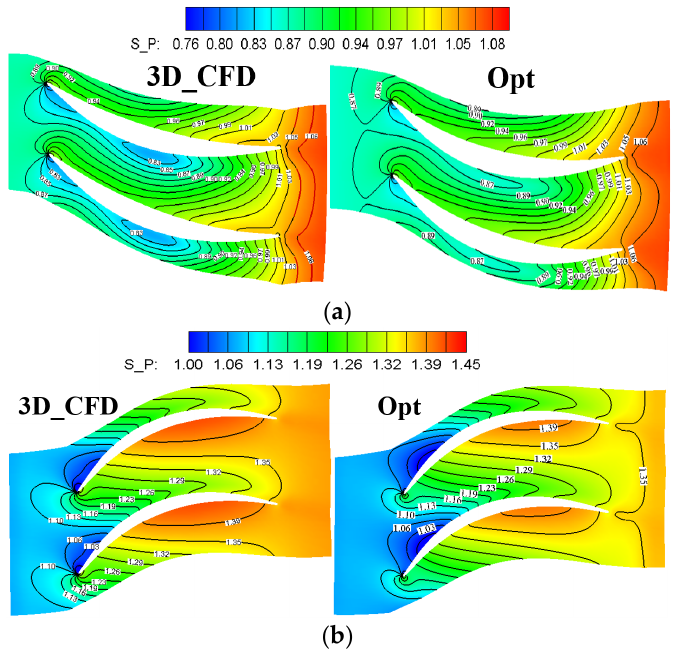
Figure 17. The cloud chart of static pressure at the 0.5% span section. ( a ) Rotor1; ( b ) Stator1.